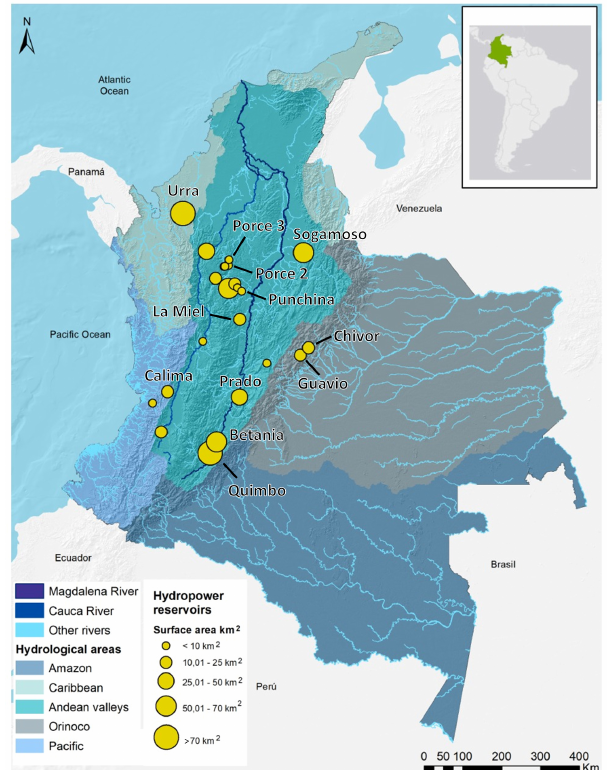
Figure 1. A map of 22 reservoir-forming hydropower stations in Colombia regulated by the Autoridad Nacional de Licencias Ambi- entales (ANLA). The labeled reservoirs are those analyzed in this study. The topographic base map is publicly available from the Sis- tema de Información Ambiental de Colombia, and the locations of the hydropower projects are provided by Sistema de Información Geográfica, maintained by Autoridad Nacional de Licencias Ambi-